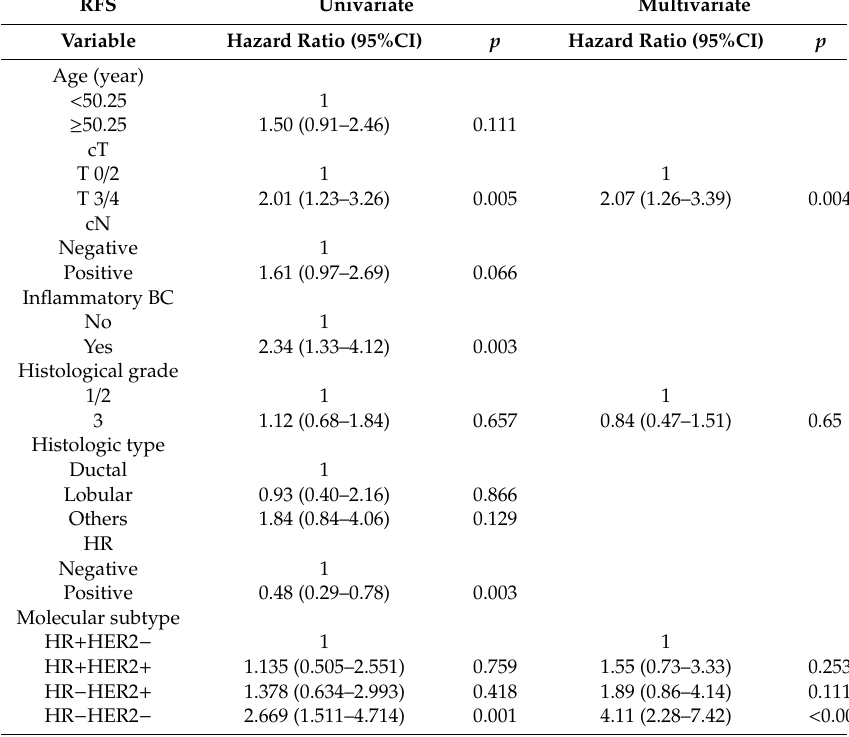
Table3. Univariate and multivariate logistic regression of prognostic factors for recurrence-free survival (RFS). Univariate